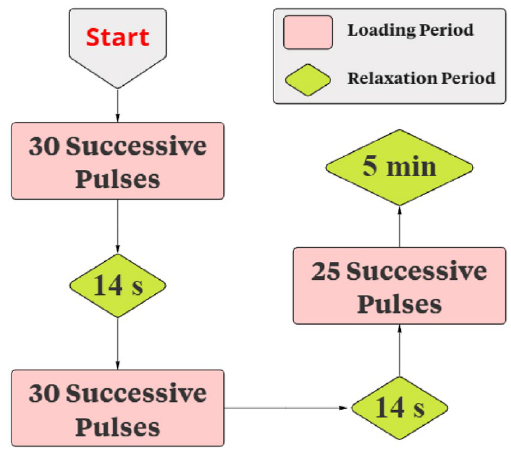
Fig. 18 Schematic representation of applied thermo-mechanical shocks